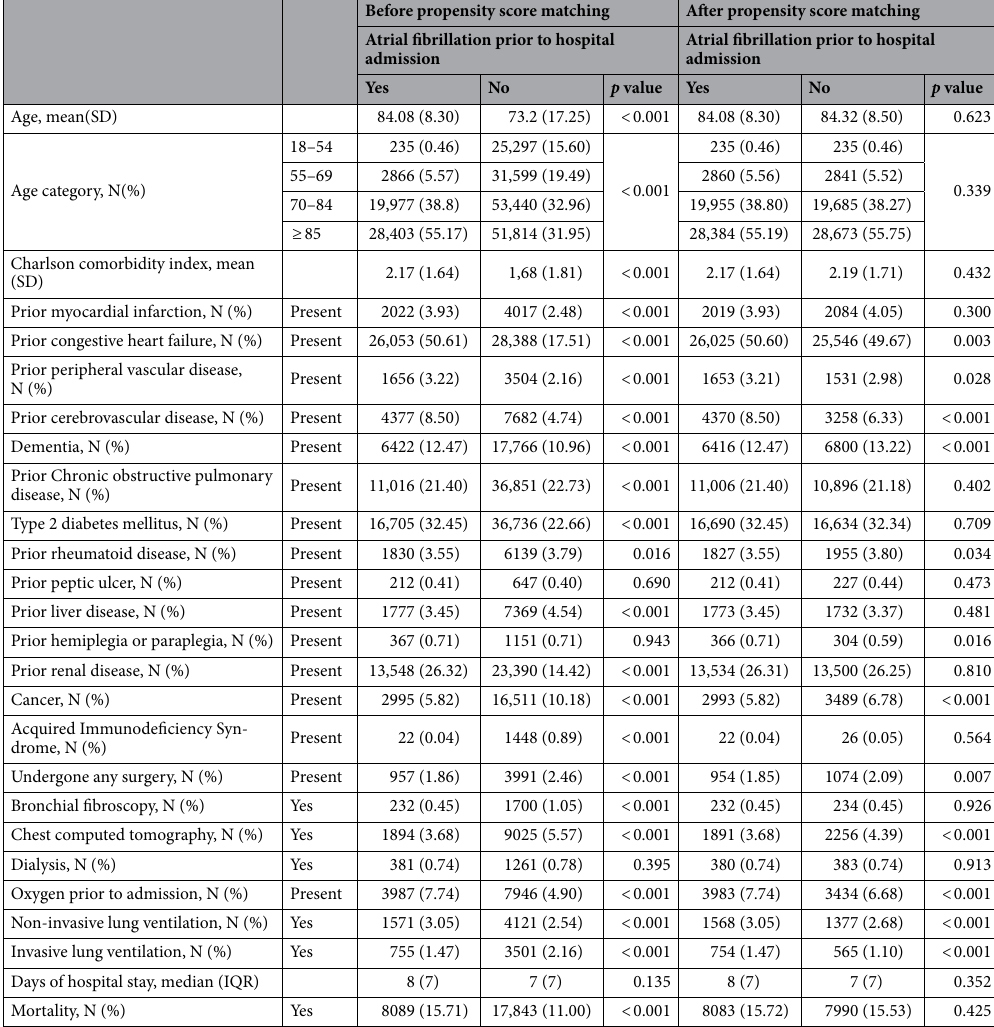
Table 2. Clinical characteristics, and in-hospital outcomes of women hospitalized with community-acquired pneumonia in Spain from 2016 to 2019 according to atrial fibrillation prior to hospital admission, before and after propensity score